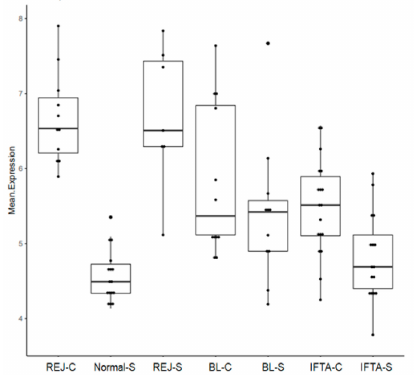
Figure 2. Rejection-associated gene score in the di ff erent study groups. REJ-C, rejection in biopsies for cause ( n = 12); Normal-S, normal surveillance biopsies ( n = 17); REJ-S, rejection in surveillance biopsies ( n = 6); BL-C, borderline changes in biopsies for cause ( n = 13); BL-S, borderline changes in surveillance biopsies ( n = 12); IFTA-C, interstitial fibrosis and tubular atrophy in biopsies for cause ( n = 20); IFTA-S, interstitial fibrosis and tubular atrophy in surveillance biopsies ( n = 16). ANOVA p -value 6.27 × 10 − 12 .